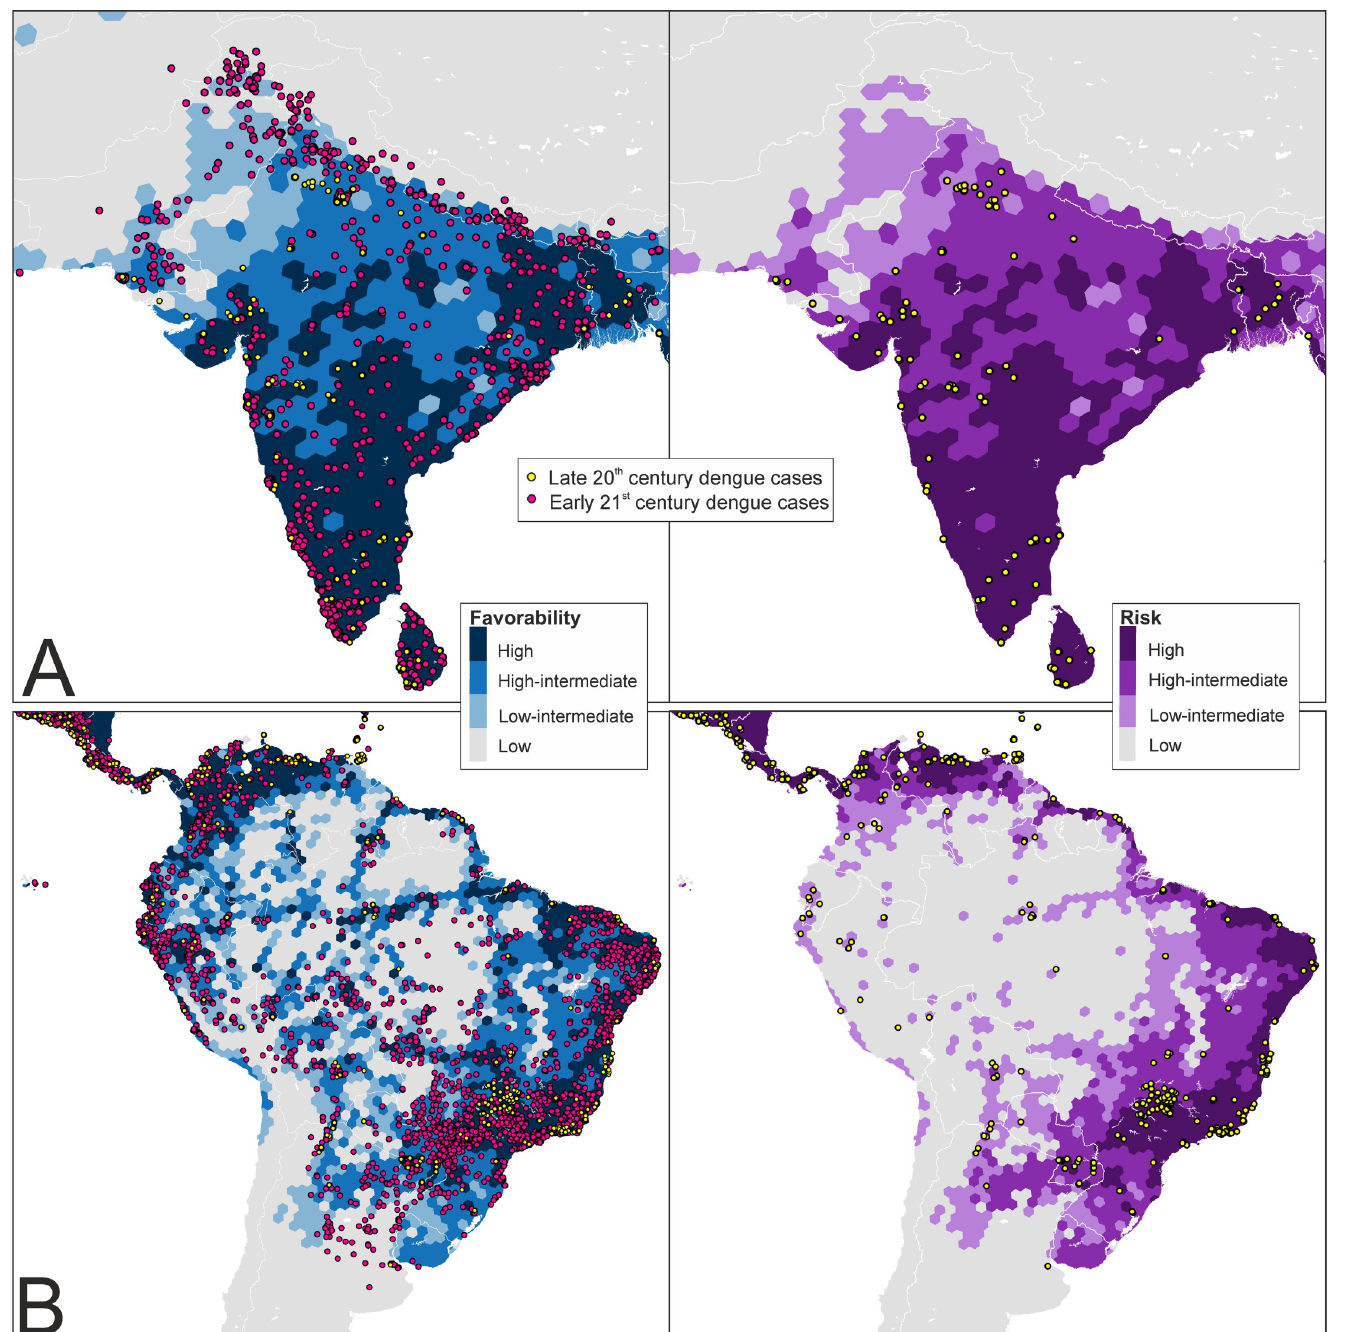
Fig 5. Late 20 th century disease and transmission-risk models in the Indian peninsula (A) and South America (B). These models were calibrated according to human- dengue cases from the late 20 th century (Fig 2A). The locations of dengue cases recorded in the late 20 th and the early 21 st centuries are shown in order to illustrate the predictive capacity of these models (see explanations and implications in the main text). See early 21 st -century models and data for these areas in S8 Fig. Coast lines source: